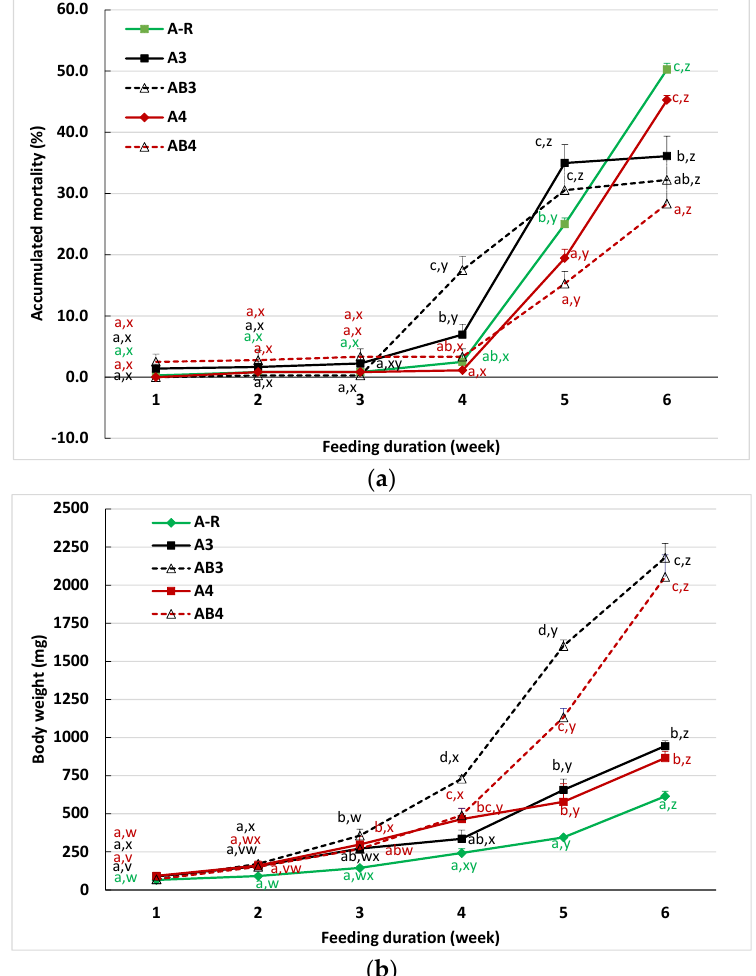
Figure 3. Accumulated mortality ( a ) and average body weight ( b ) of sturgeon fed with different dietary strategies for six weeks (Trial II). Data are presented as the mean of three replicates. Means within the same feeding time were compared using letters a, b, and c to indicate significant differences among feeding treatments determined by Tukey’s HSD test ( p < 0.05). Letters x, y, and z compare the difference of different sampling times within the same feeding treatment. See the footnote of Table 3 for the information on feeding treatments.